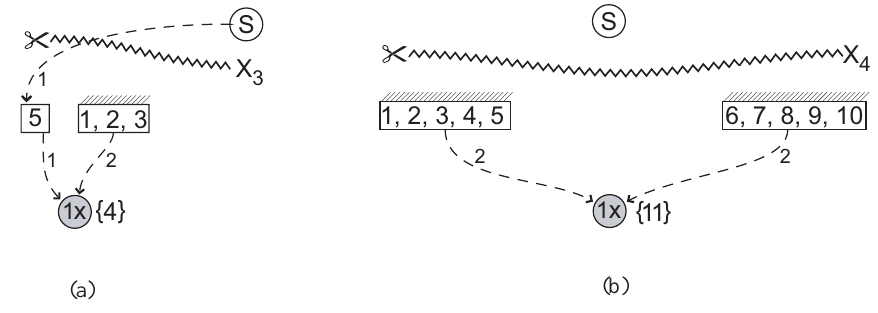
Figure 10. Minimal cuts and resulting DOFs for each